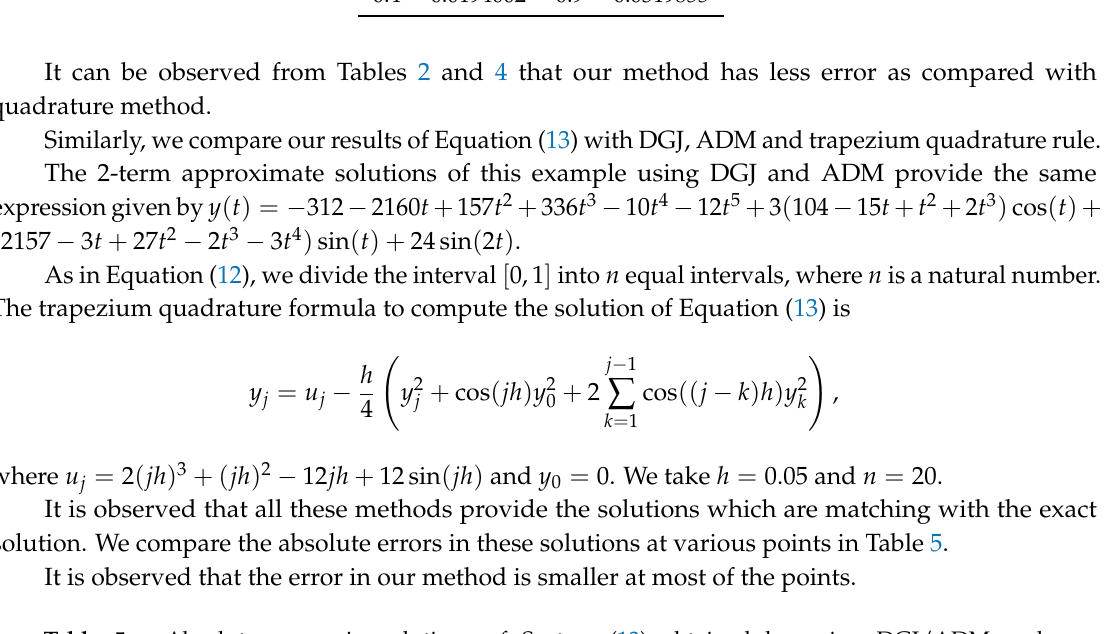
Table 5. Absolute errors in solutions of System (13) obtained by using DGJ/ADM and quadrature